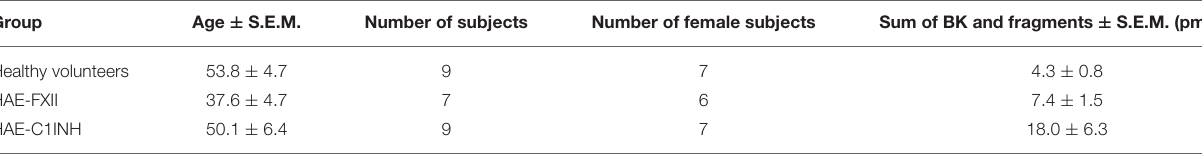
* Statistics reported in Figure 1 .